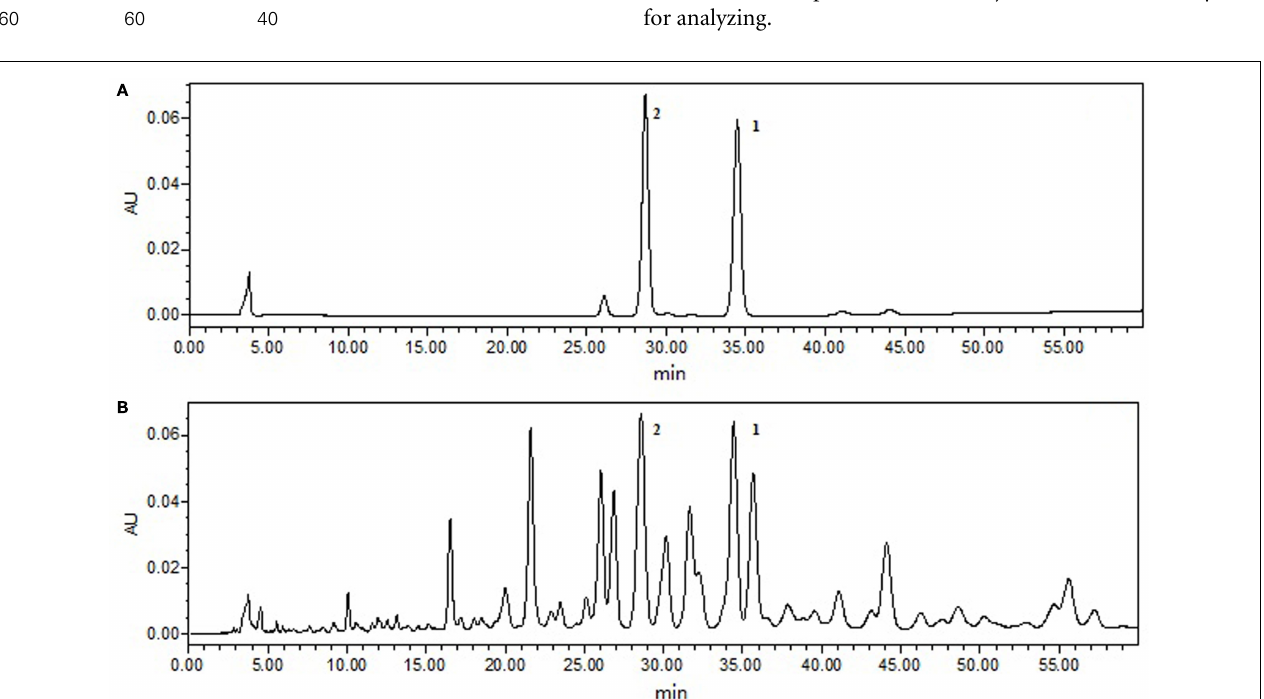
FIGURE 1 | Mixed reference substance (A) and Ganoderma lucidum extraction (B) UPLC spectra.